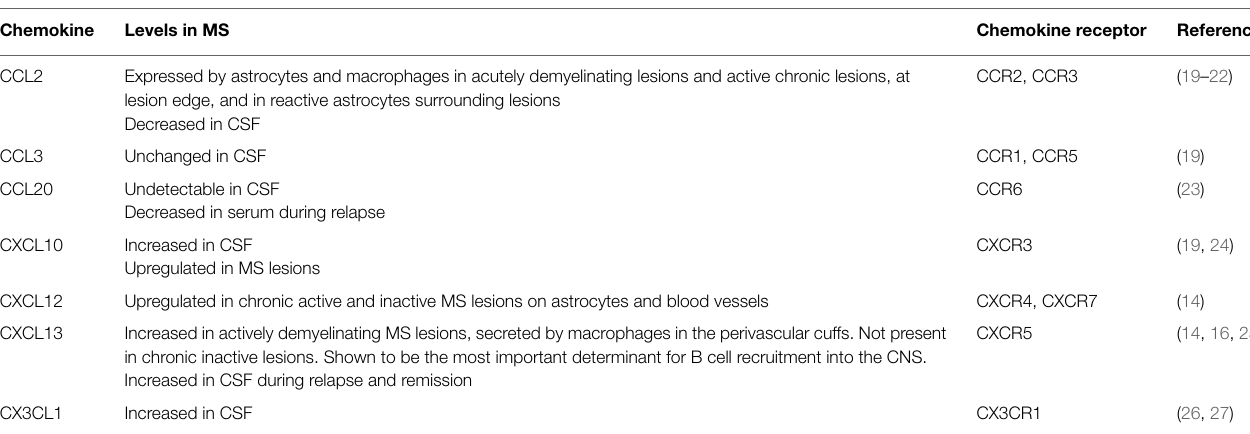
TABLE 1 | B cell chemokines in multiple sclerosis .